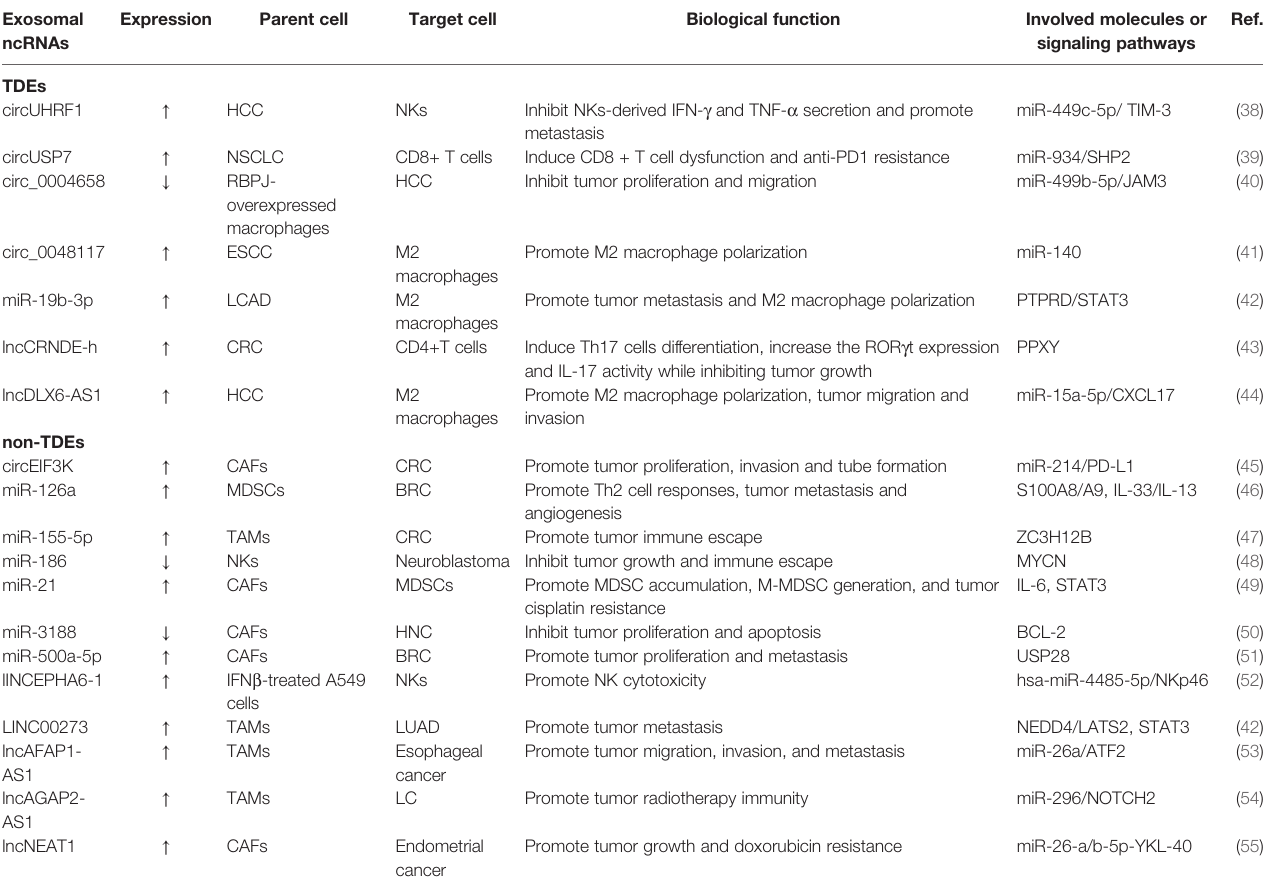
TABLE 1 | Exosomal ncRNAs in cancer